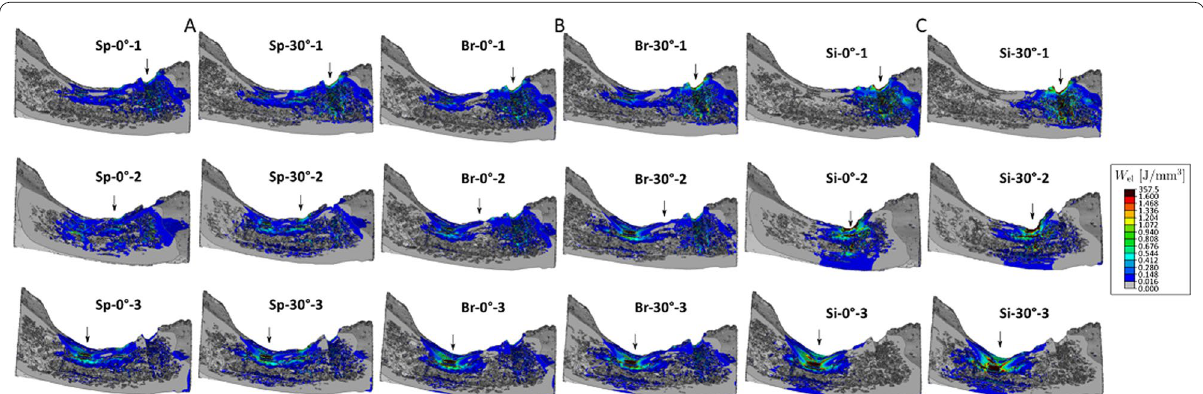
Fig. 6 Strain energy density (SED) shown for every load case of tested configurations. A Splinted crowns configurations. B Bridge configurations. C Single crowns configurations. Deformation scale factor: 600 of overload (above 1.6 J/mm 3 (dark red); 100 N applied, instead of physiological value of 500 N, rescale factor mm 3 0.2 0.2 0.8 J/mm 3 × × =